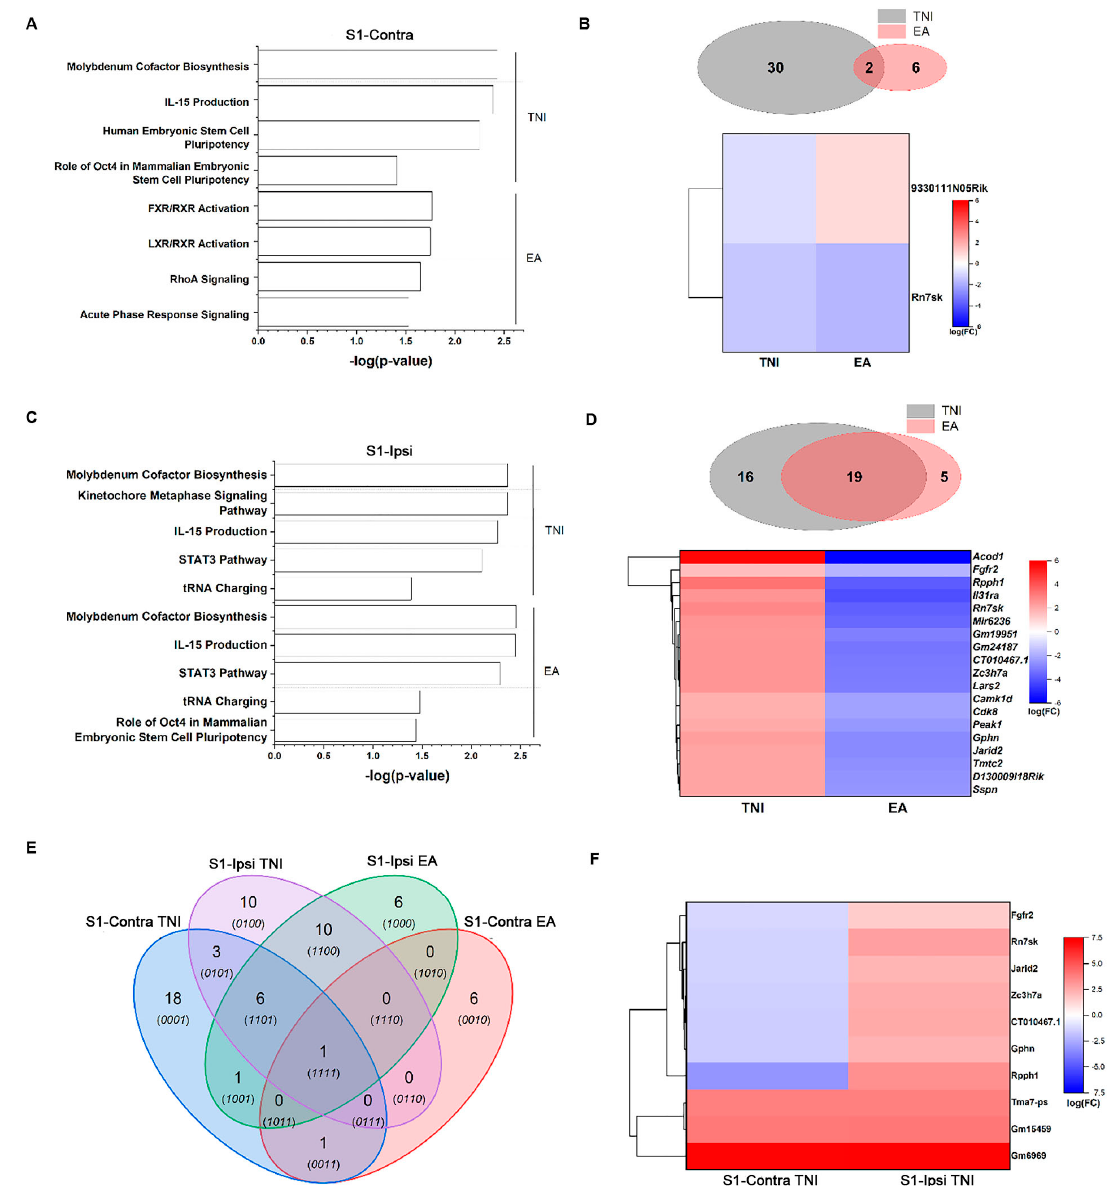
Figure 3. Top canonical pathways identified based on DEGs of TNI and sham (termed as TNI) and electroacupuncture − treated and TNI (termed as EA, bottom) for contralateral ( A ) and ipsilateral ( C ) S1 regions in mice cortex. Venn diagrams of DEGs arising from TNI and EA are summarized in ( B ) and ( D ) ( top ) with an expression map for common genes ( bottom ) for the contralateral and ipsilateral S1, respectively. ( E ) Venn diagram showing common genes among different treatment groups in the contralateral and ipsilateral S1. ( F ) Common DEGs shared between contralateral and ipsilateral S1. N =